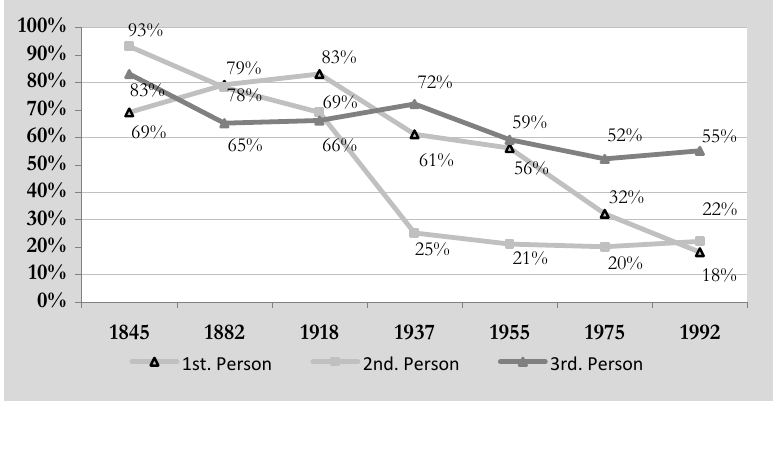
Fig. 1. Null (vs. overt) subjects across seven synchronies (From Duarte